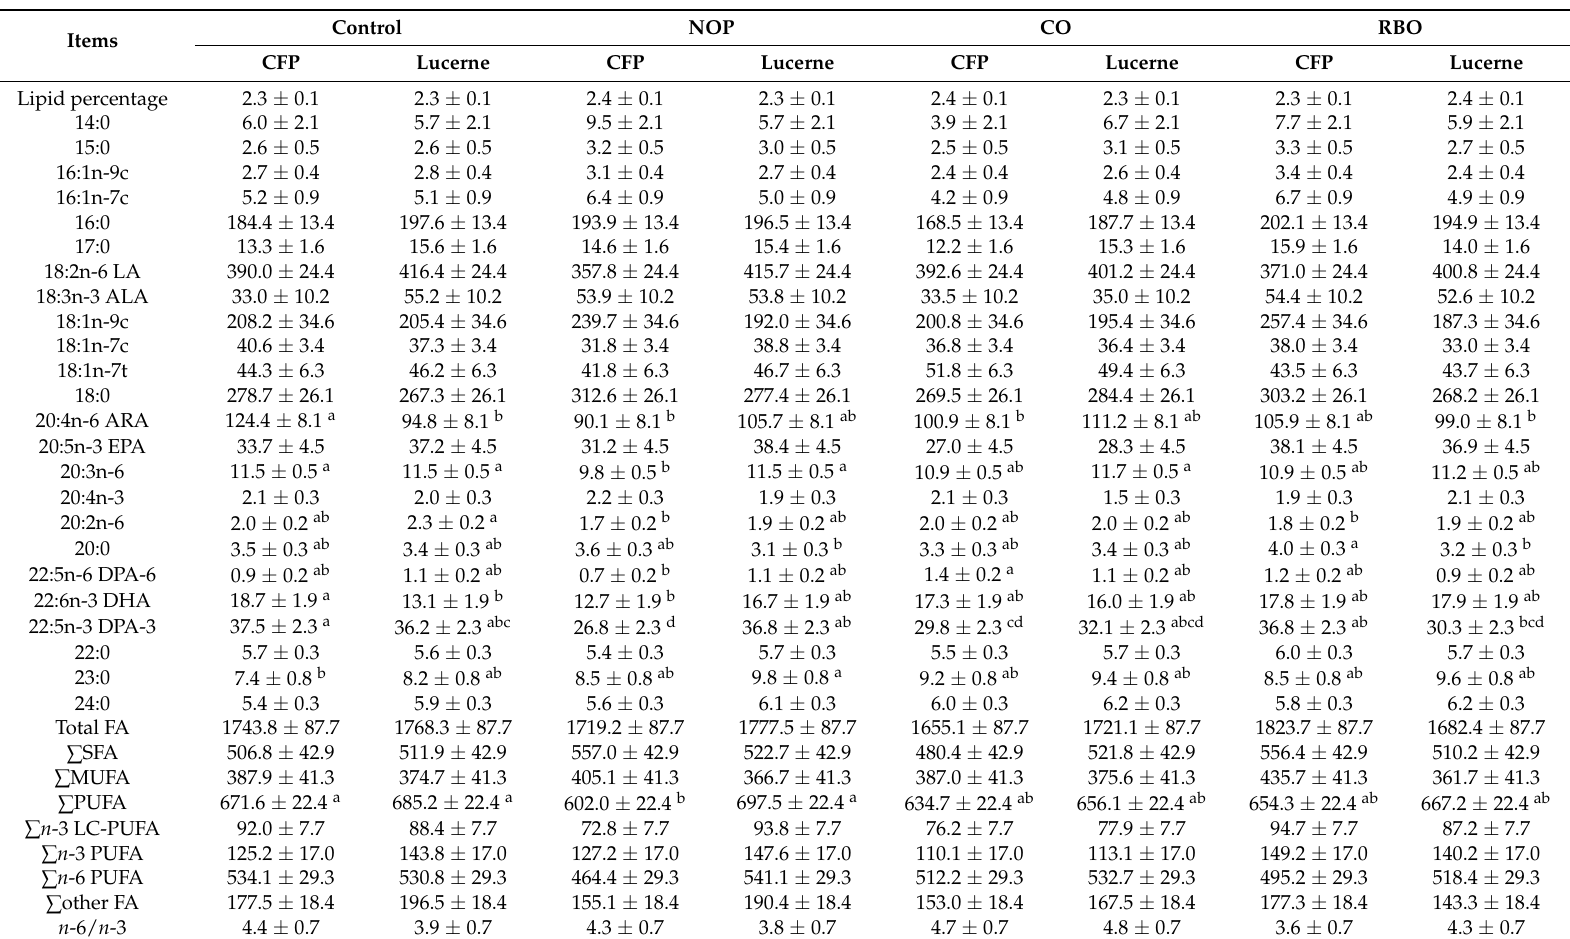
Table 5. Effect of pellet supplementation on total lipid percentage (g fat/100 g) and fatty acid contents (mg/100 g) in heart of grazing prime lambs (LSM ± SE)